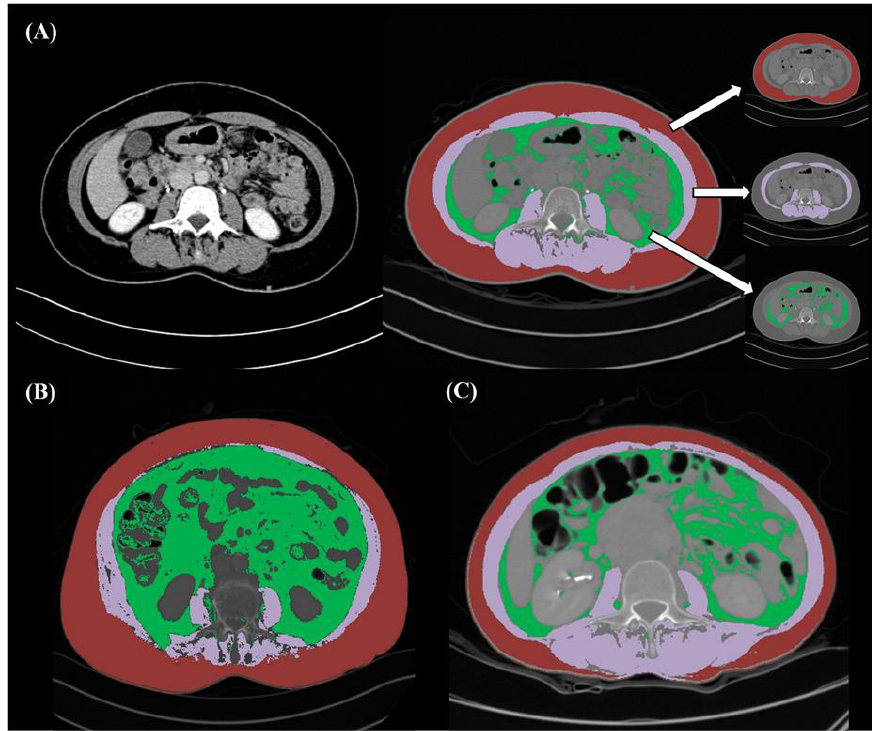
Figure 4. Evaluation of body composition using CT image. Preoperative axial CT image at the level of L3 vertebral body level. ( A ) A 52-year old woman with newly diagnosed high-grade serous ovarian carcinoma. Total abdominal muscle area (purple), visceral fat area (green), and subcutaneous fat area (red) are segmented by the semi-automatic technique; ( B ) A 73-year old woman with sarcopenia and high fat-to-muscle ratio (4.6); ( C ) A 53-year old woman with sarcopenia and low fat-to-muscle ratio (1.5).